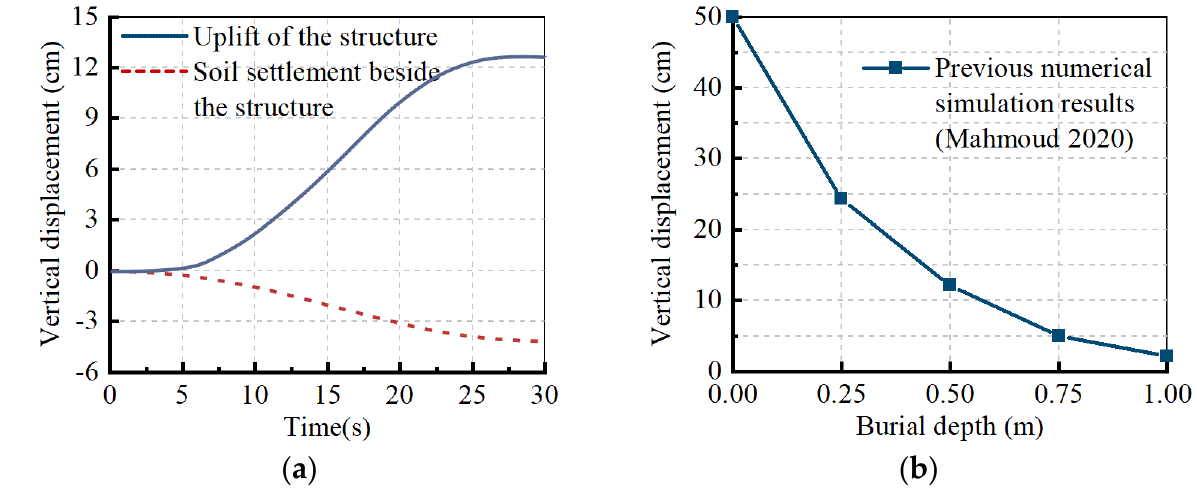
Figure 17. Mahmoud et al. (2020) [7] numerical simulation results: ( a ) time histories of vertical displacement of the midpoint of the top slab and the surrounding soil, and ( b ) vertical displacement at the midpoint of the top slab at different burial depths.